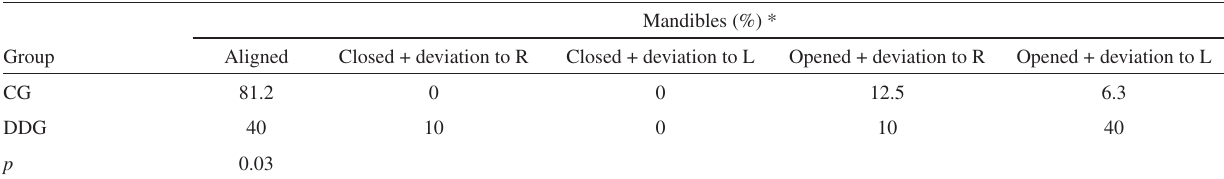
Table 4 – Postural assessments of the mandibles in the frontal plane, with mouth open and